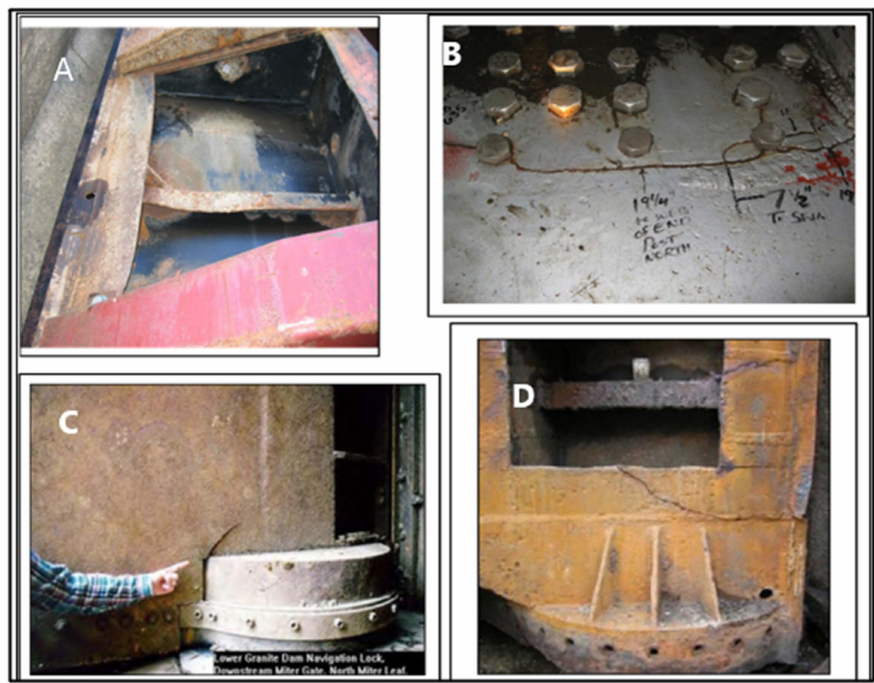
Figure 7. Distress features in horizontal miter gates caused by Quoin block deterioration, ( A ) out of plane deformation near Quoin block, ( B ) cracks propagate around bolts, ( C ) crack at the pintle, ( D ) crack above